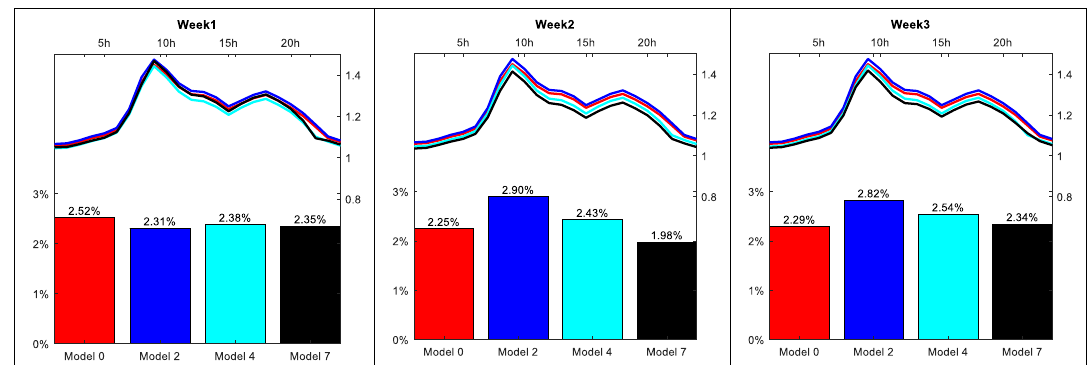
Figure A5. Christmas periods.